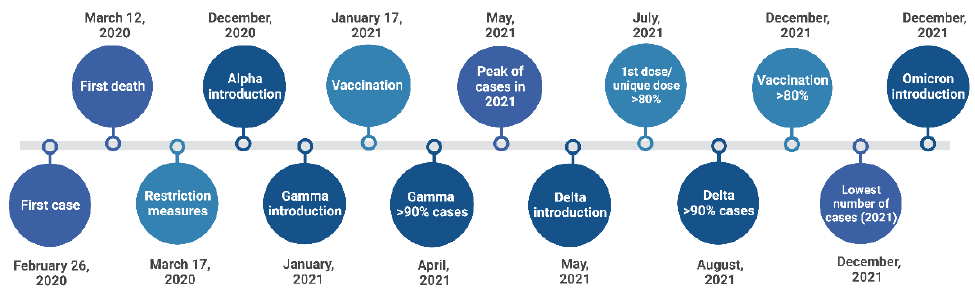
Figure 1. Summary of main events of the COVID-19 epidemic in São Paulo City.